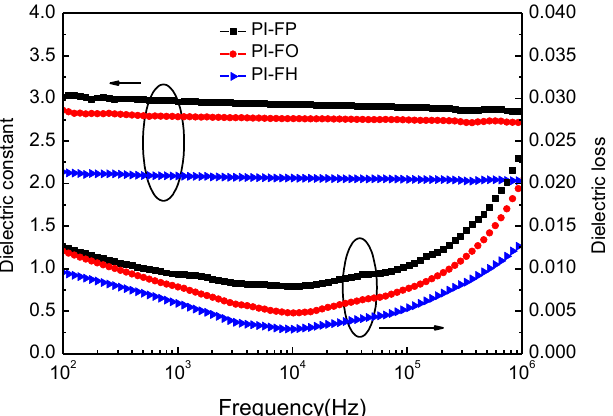
Figure 6. The relation between absorption coeffi- cient spectra and the energy gap. Table 3. The cut-off wavelength and highest transmittance of PI films.